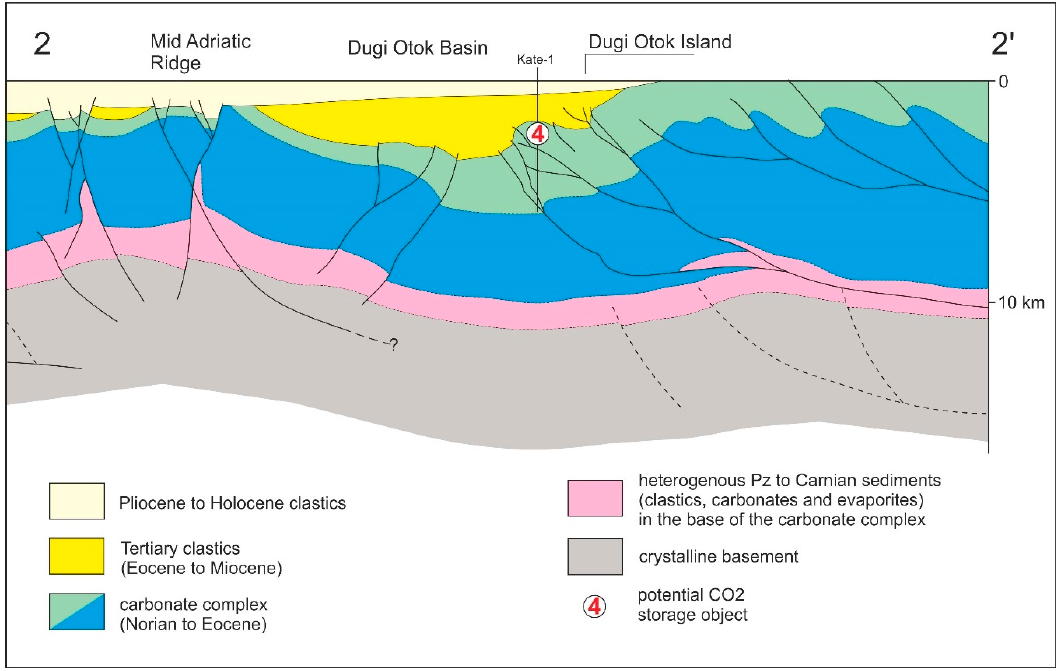
Figure 6. Transversal cross-section 2–2 ′ through the deep well Kate-1, south of the Dugi otok island (after [30]; stratigraphy modified after [15]). Vertical exaggeration is 2:1. Fault planes are marked with black lines. Location in Figures 3 and 4.